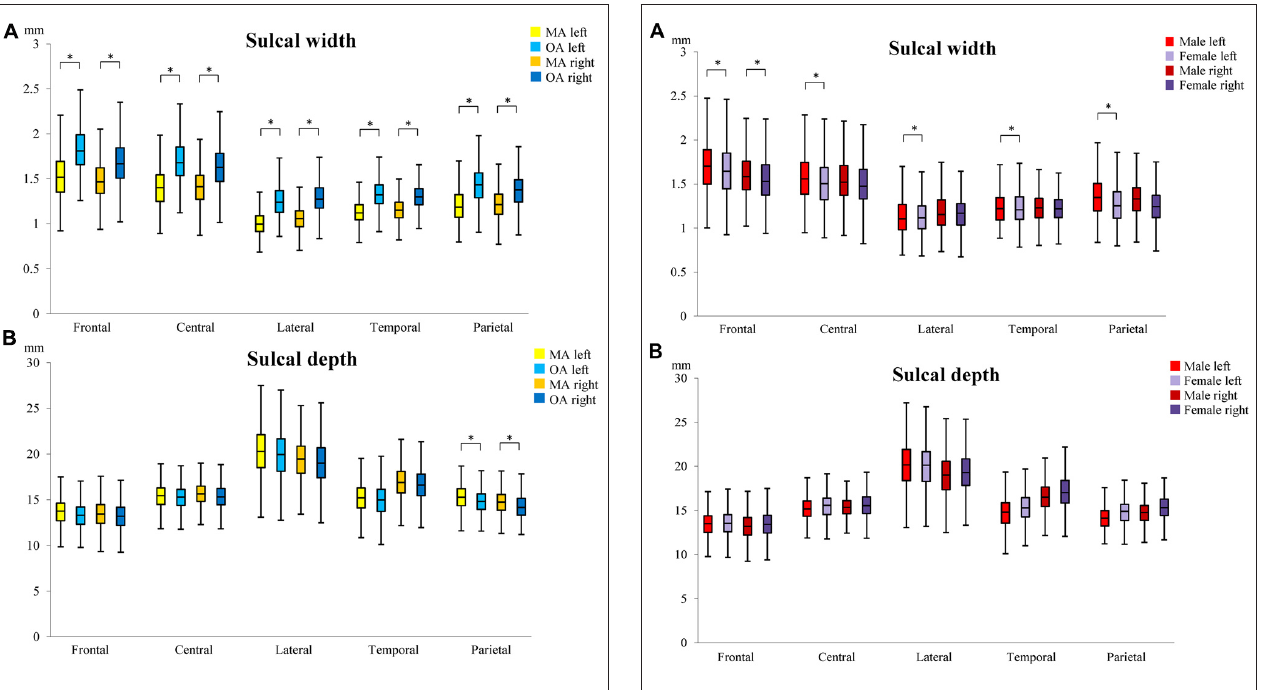
FIGURE 4 | Differences in sulcal width (A) and depth (B) between males and females. The median, 1st and 3rd quartile range of sulcal widths and depths in MA and OA are shown. Whiskers show minimum and maximum value. ∗ Indicates significant ( p < 0.01) sex by age group differences in sulcal width/depth. Superior frontal sulcus (frontal); central sulcus (central), lateral sulcus (lateral); superior temporal sulcus (temporal); intra-parietal sulcus